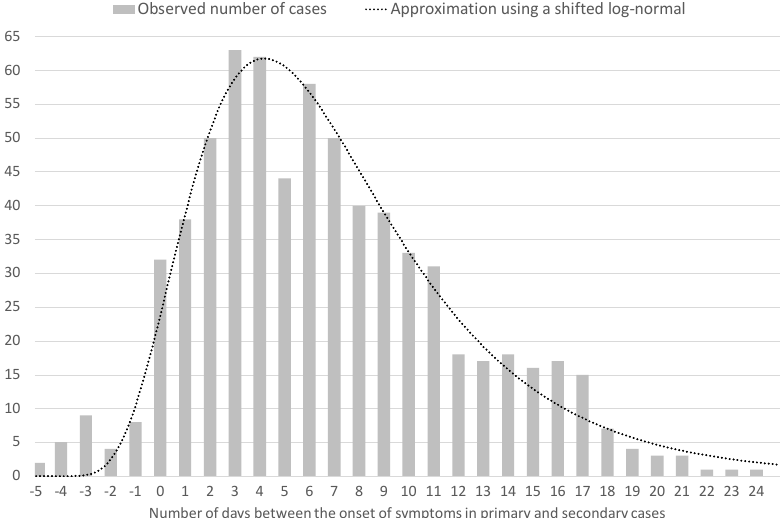
Figure 1. The serial interval Φ s obtained by [4]. The bars represent the observed number of cases in function of the number of days between the onset of symptoms in primary and secondary cases. The dotted line is its approximation by a scaled and shifted log-normal